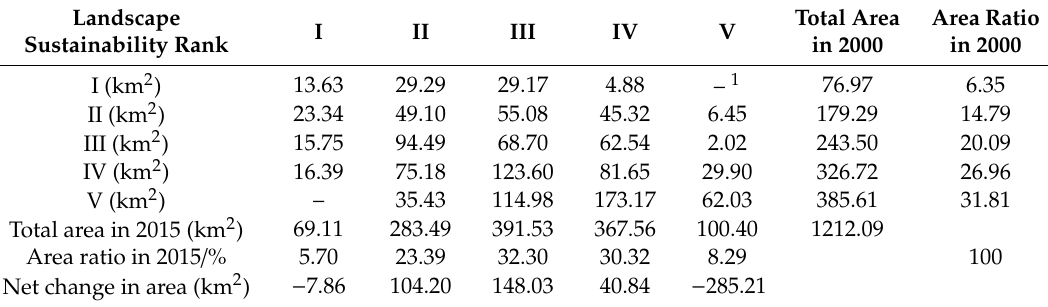
Table 3. Transition matrixes of landscape sustainability of basins area during